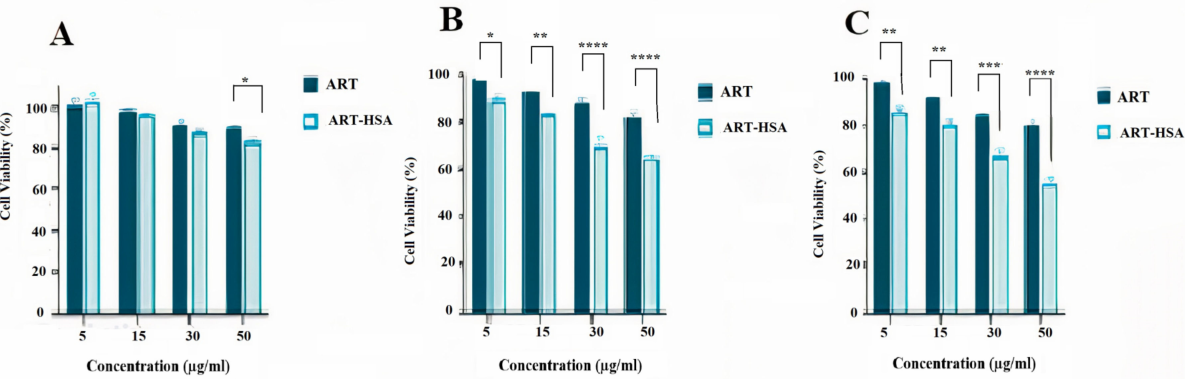
Figure 5. Results of artemether and nanoparticle cytotoxic effect on CT26 cell line in 24 ( A ), 48 ( B ), and 72 ( C ) h. Asterisks show the statistically significant difference between various treatments.